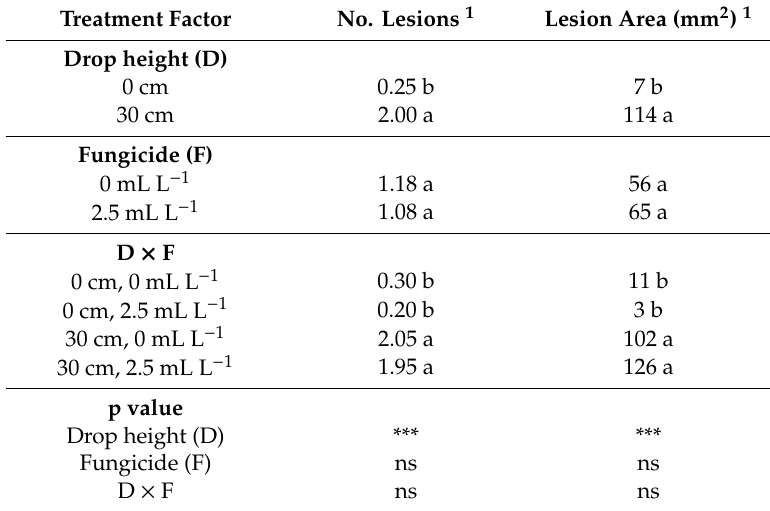
Table 8. Influence of impact at packing and postharvest fungicide treatment on body rot expression inside the impact site in ‘Hass’ avocado fruit from Experiment 8 as assessed at soft-ripe